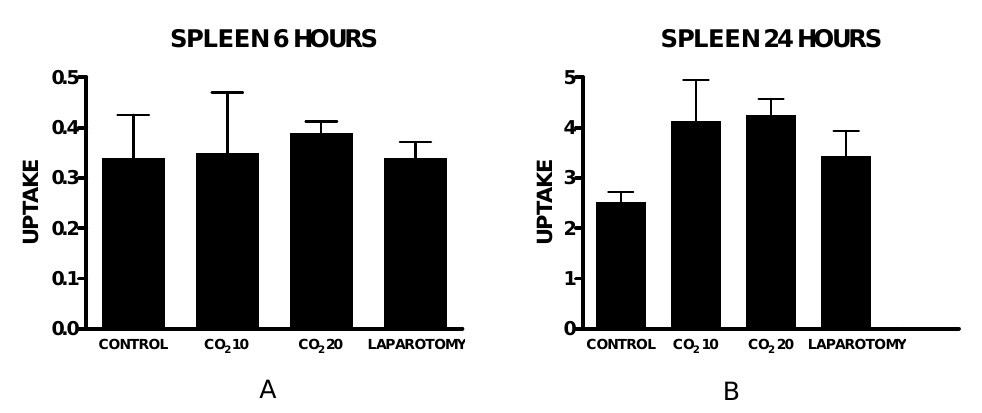
FIGURE 2 - Technetium-99m uptake in the blood after six hours (A) and 24 hours (B). Each bar represents the mean ± SEM of six animals. There were no statistically significant variations between the groups